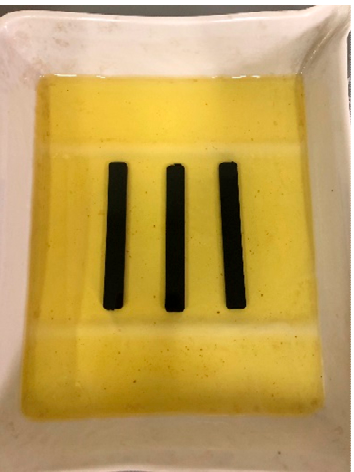
Figure 15. Plastic samples immersed in aviation fuel.